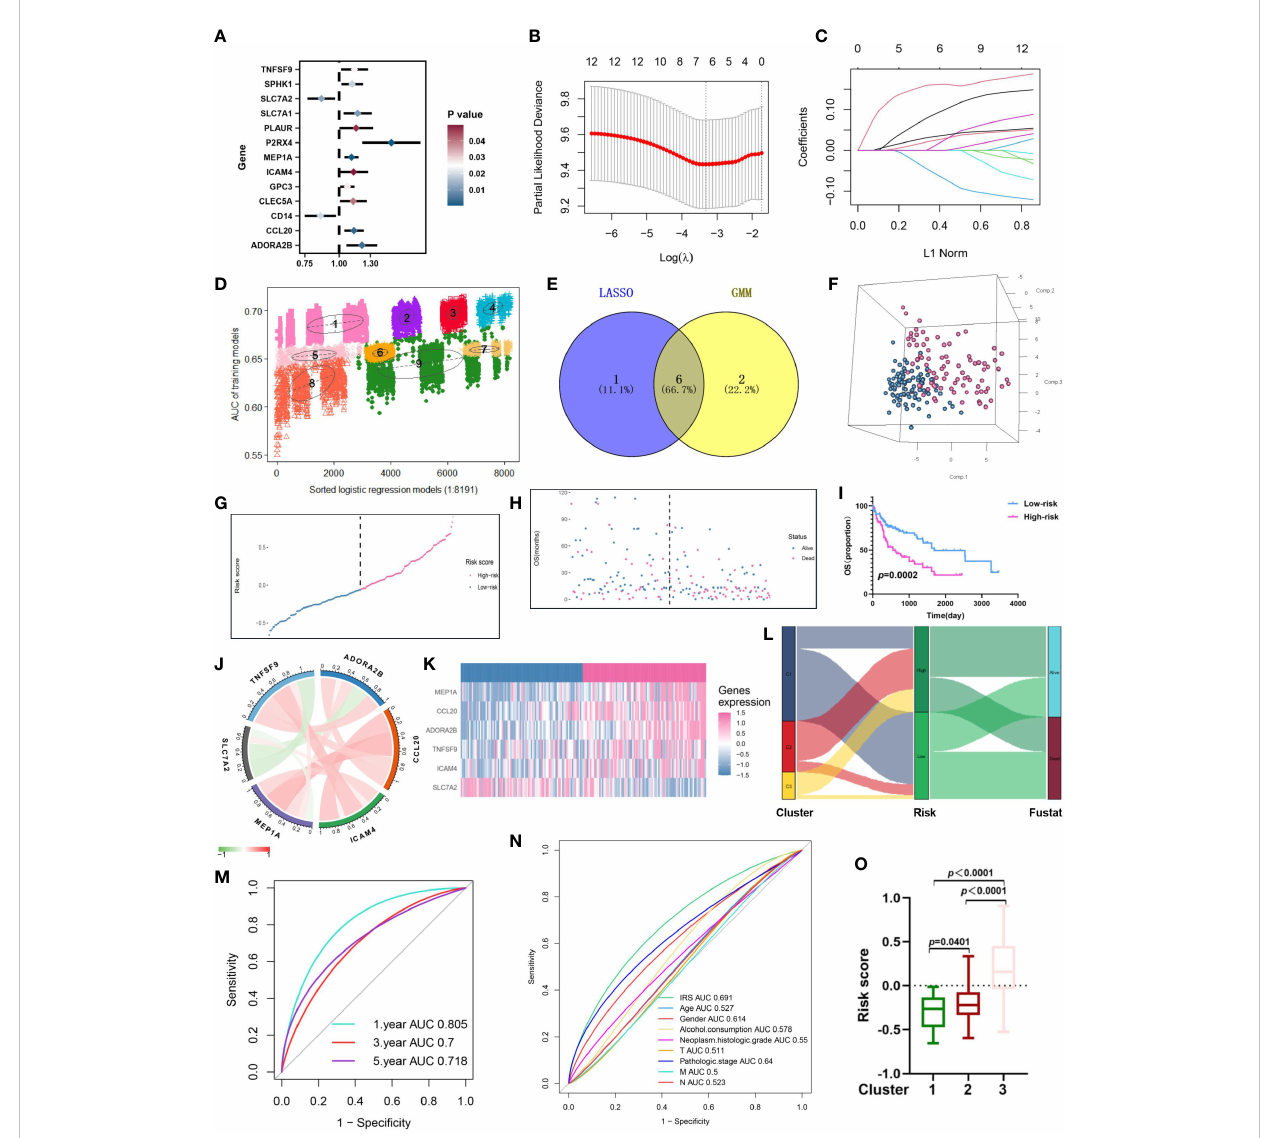
FIGURE 5 Construction of an in fl ammation-related risk model to predict the OS of virus-related HCC patients. (A) 13 prognosis-related IRGs screened by univariate Cox regression analysis (p<0.05). (B) The tuning parameter ( l ) in the LASSO model is chosen by the minimum criterion. (C) LASSO coef fi cient distribution of 13 in fl ammation-related IRGs. (D) The pattern of the logistic regression model correlated with the AUC scores and was identi fi ed by a Gaussian mixture model. There are nine clusters of 8191 combinations. (E) Venn diagram of the shared genes by comparing LASSO model to GMM model. (F-H) Principal component analysis, risk score distribution, and survival status distribution for virus-related HCCs from TCGA- LIHC database. (I) Kaplan-Meier analysis of the OS between the high group and low group. (J) Co-expression network of the hub IRGs. (K) Expression patterns of 6 hub prognostic IRGs in high- and low-risk groups. (L) Alluvial diagram of subgroup distributions in groups with different IRG scores and clinical outcomes. (M) ROC curves for 1 year, 3 years and 5 years. (N) ROC analysis showed that the predictive accuracy of IRG was superior to other clinical features. (O) Differences in IRG score between the three gene